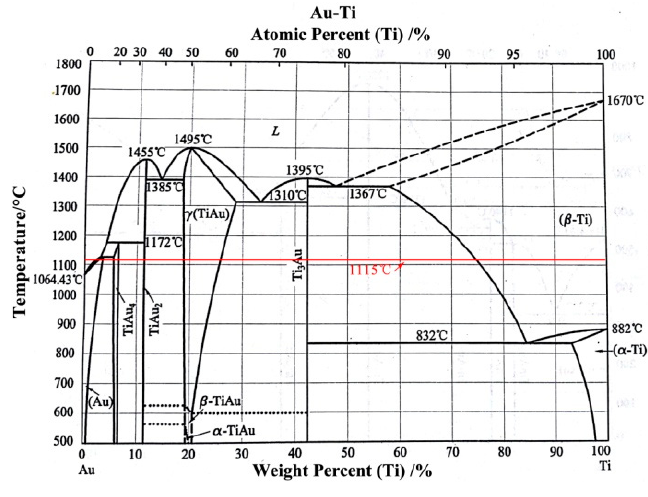
Figure 4. Ti–Au binary phase diagram.